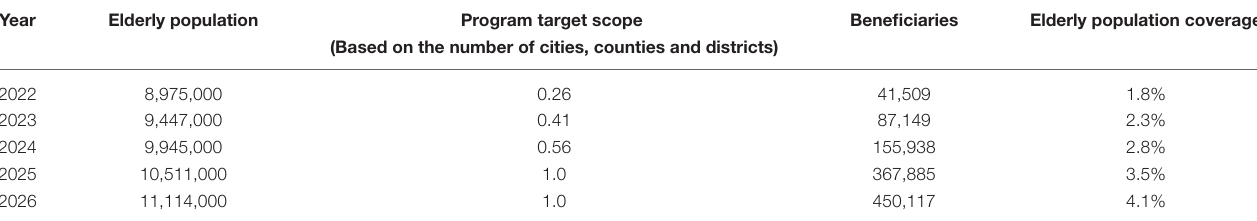
TABLE 10 | Estimation of recipients of the integrated care for the elderly in the local community according to the expansion of the target